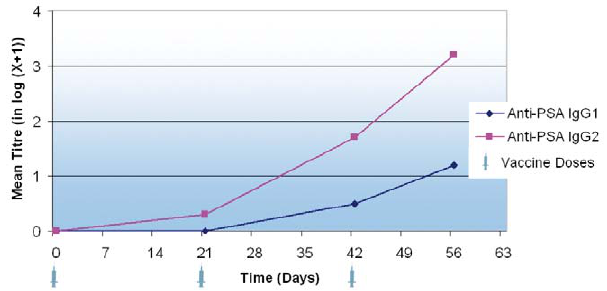
Figure 2. Progression in log-transformed anti-PSA IgG1 and IgG2 titres during the onset of immunity. The data presented here are the means of the log-transformed titres. The titre is taken to be the first dilution with an optical density of less than 0.4 measured at 405 nm. The sera were tested using a PSA-coated ELISA at days 0, 21, 42 and 56. PSA is a dominant antigen in ESP and therefore a key antigen in the vaccine.